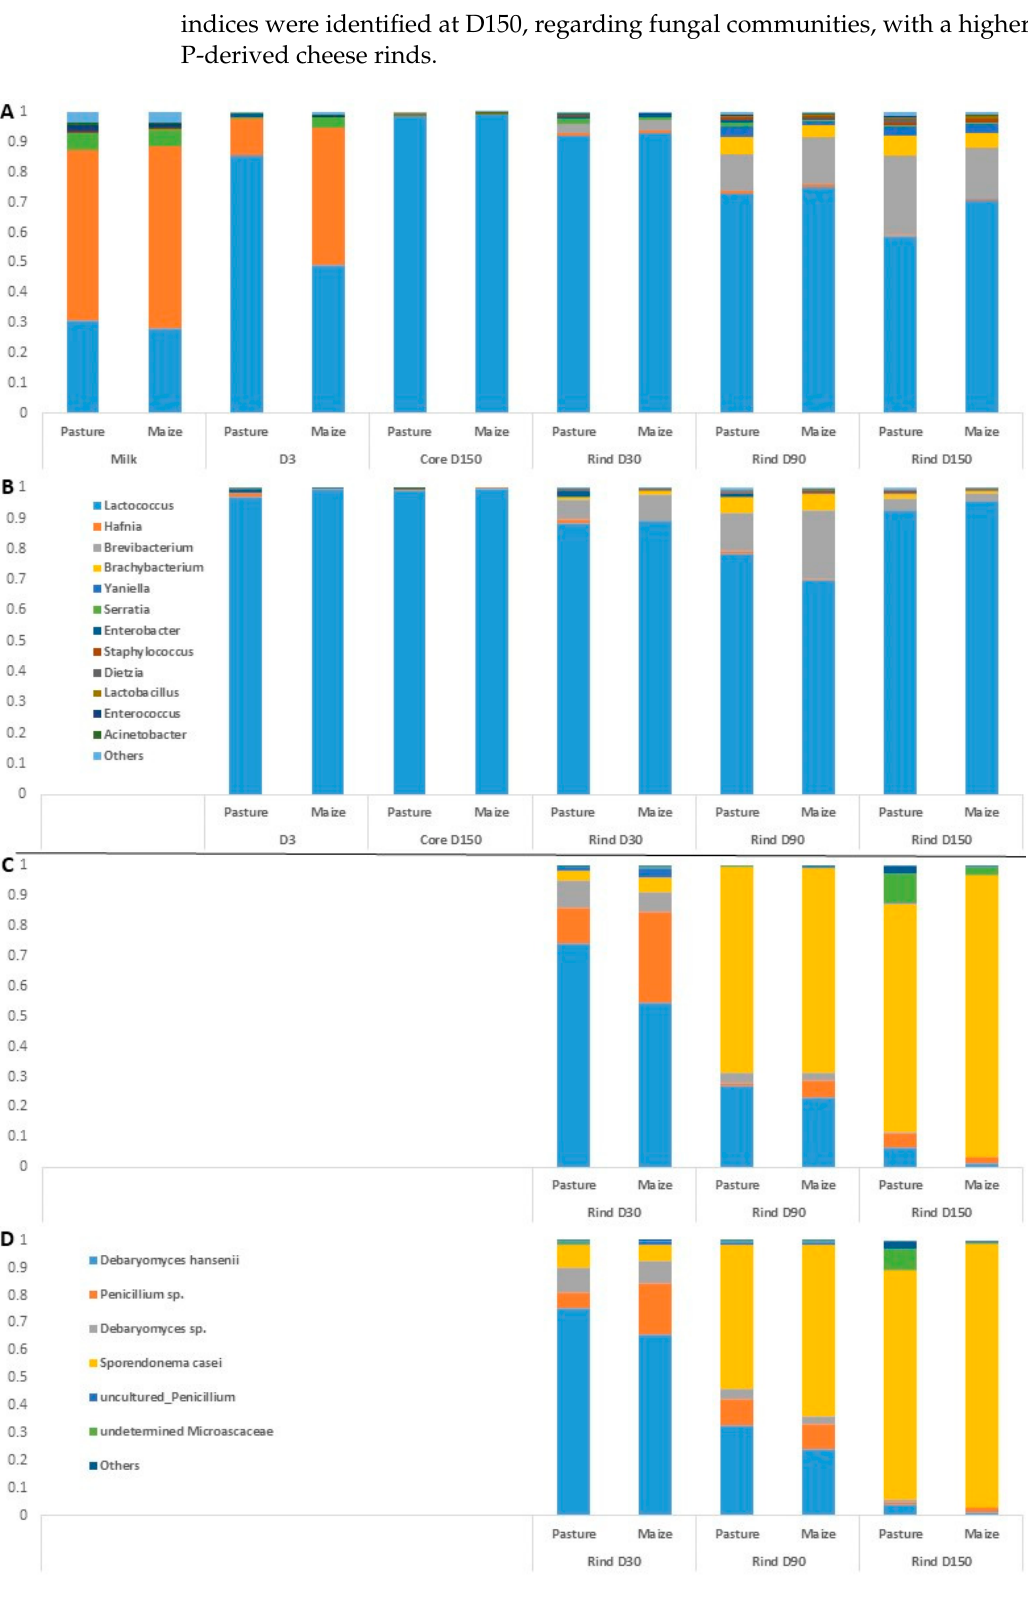
Figure 2. Average relative abundances ( n = 3) of the major bacterial ( A , B ) and fungal ( C , D ) taxa in milks and cheeses according to cream origin. ( A , C ) Cantal manufactured from raw milk; ( B , D ) Cantal manufactured from pasteurized milk; only genera with relative abundances > 1% in at least one type of sample are plotted.